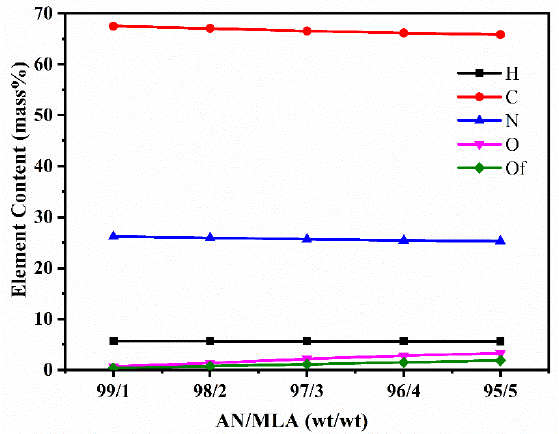
Figure 3. The results of P (AN- co -MLA) copolymers with various mass feed monomer ratios through elemental